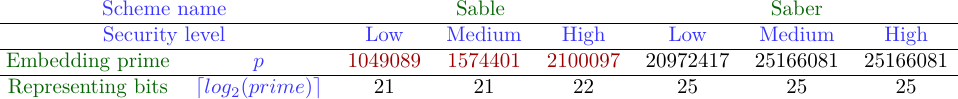
Table 7: Comparison of prime used in embedded Sable and embedded Saber.